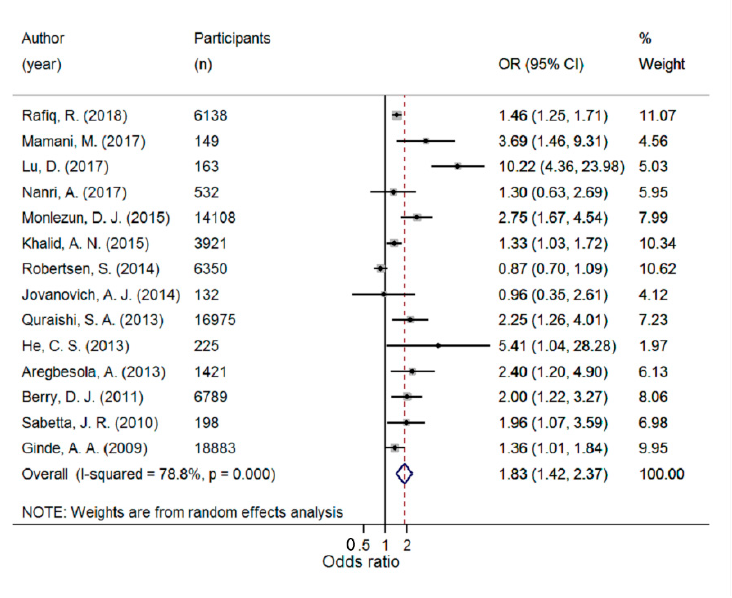
Figure 2. Forest plot displaying odds ratios (OR) and 95% confidence intervals (95% CI) for the association between 25(OH)D concentration and acute respiratory tract infection, comparing the lowest versus the highest 25(OH)D category.